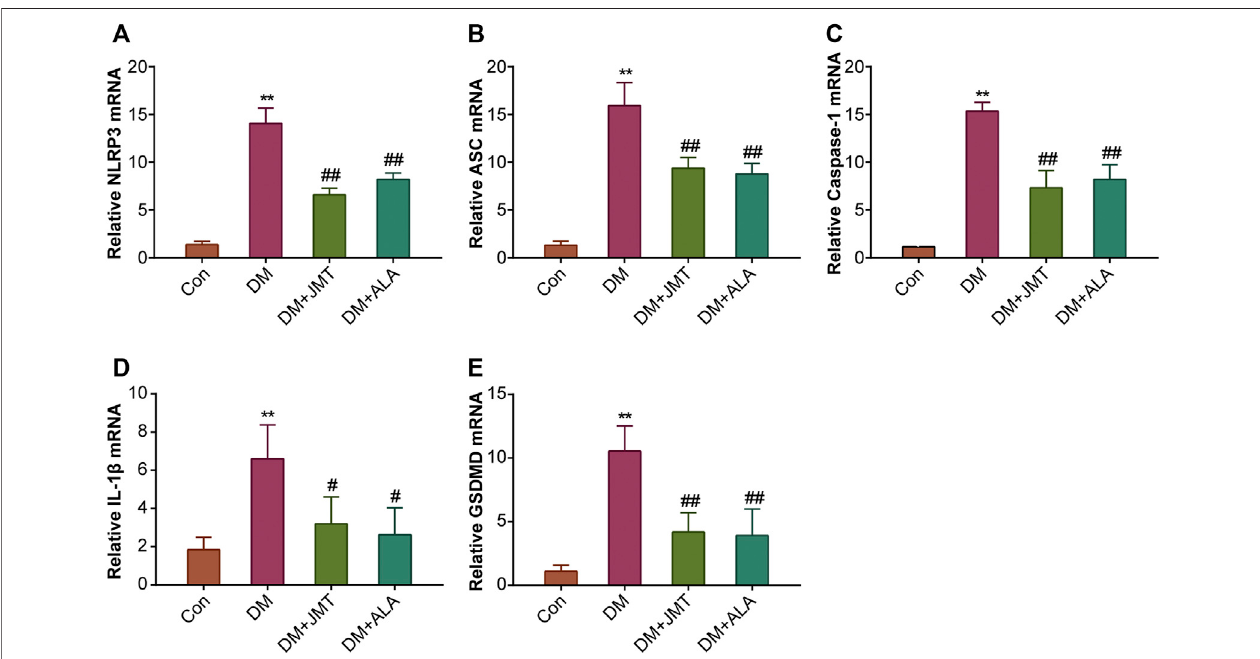
FIGURE 4 | Effects of JMT on the mRNA levels of NLRP3 in fl ammasome components and GSDMD in DRG of diabetic rats (A) NLRP3 (B) ASC (C) caspase-1 (D) IL-1 β and (E) GSDMD mRNA levels were measured by qPT-PCR analysis. Results were expressed as relative mRNA levels of target genes compared with the Con group. The data are presented as mean ± SEM (n (cid:1) 3 per group). ** p < 0.01 vs Con group, # p < 0.05 vs DM group, ## p < 0.01 vs DM group. Con, control; DM, diabetes mellitus; ALA, alpha-lipoic